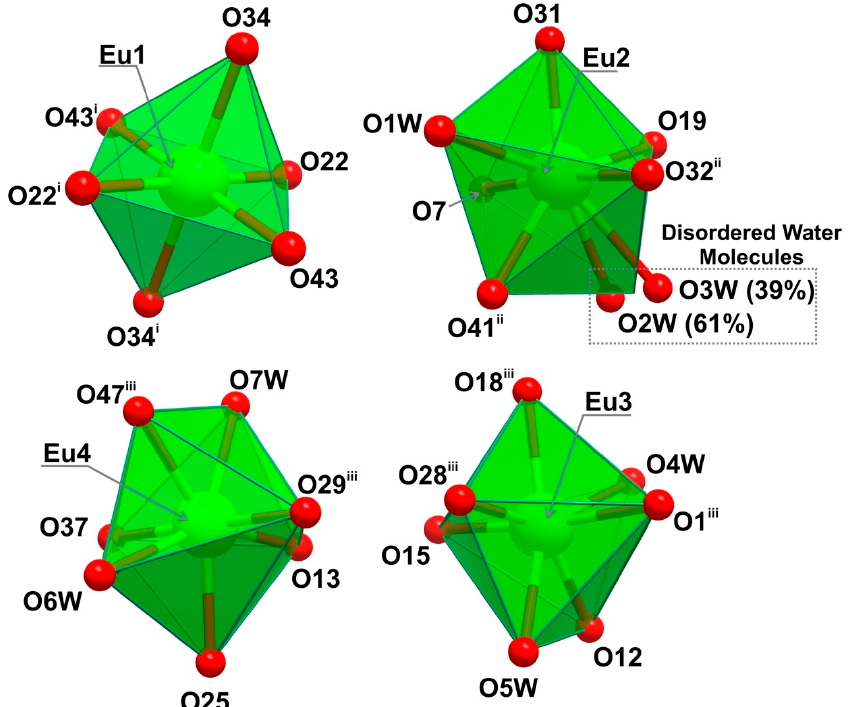
Figure 1. Polyhedral representation of the four distorted Eu 3+ coordination environments present in the crystal structure of [Eu 7 (H 5 btp) 4 (H 5.5 btp) 2 (H 6 btp) 2 (H 2 O) 12 ] ∙ 23.5H 2 O ∙ MeOH (1Eu). Table S1 (in the Supporting Information) gather all the geometrical details on the represented bond lengths, angles. Symmetry transformations used to generate equivalent atoms: (i) − x, 1 − y, 1 − z; (ii) − x, 1 − y, -z; (iii) x, 3/2 − y, − 1/2 + z.